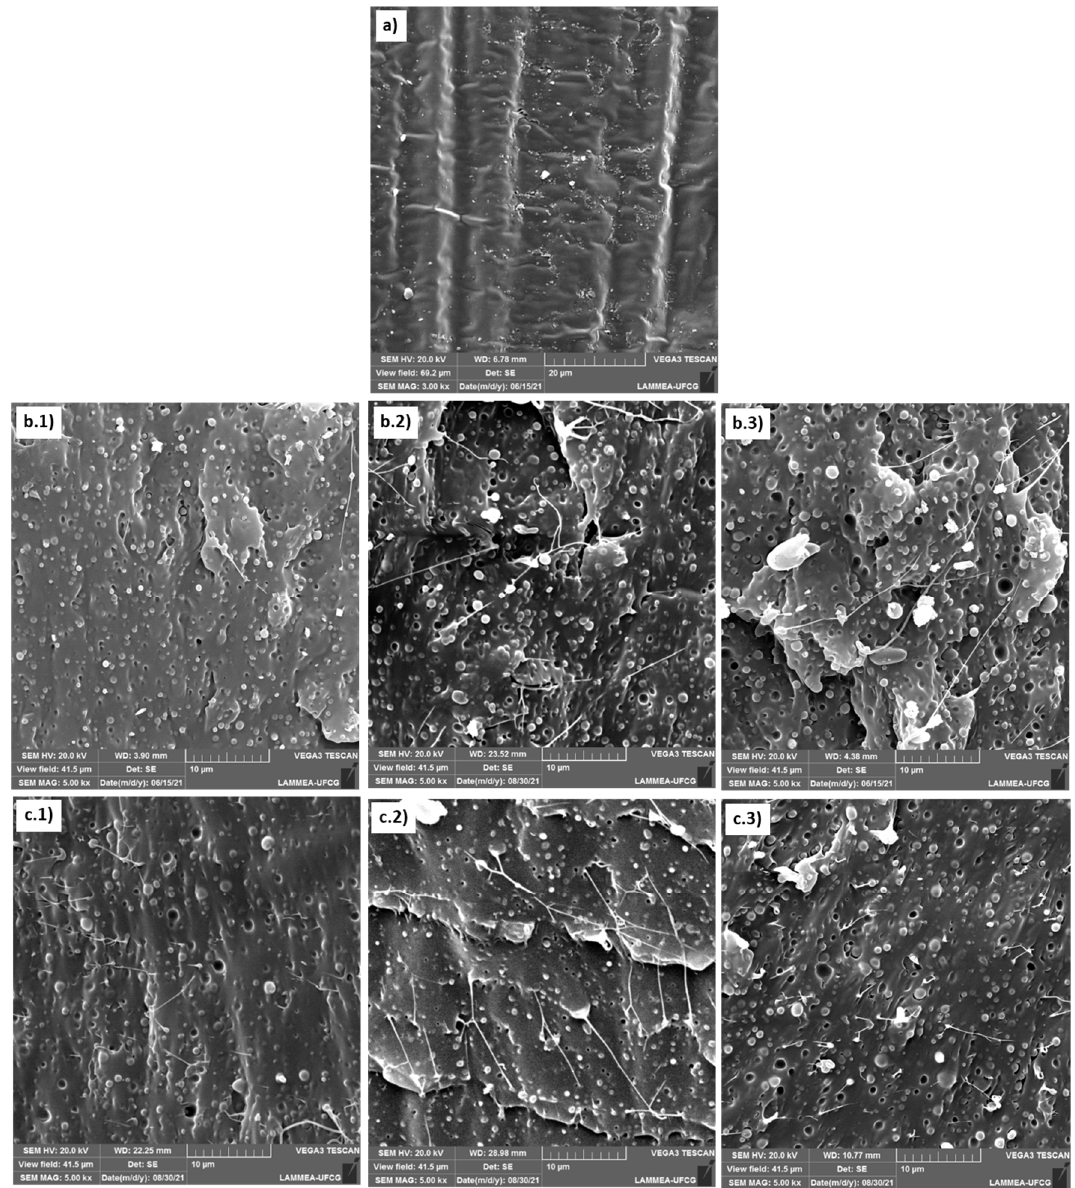
Figure 11. Micrographs obtained by SEM after impact strength test of: ( a ) pure PLA, ( b ) PLA/EE-g-GMA and ( c ) PLA/POE-g-GMA, in the proportions of: (1) 5%; (2) 7.5% and (3) 10%.